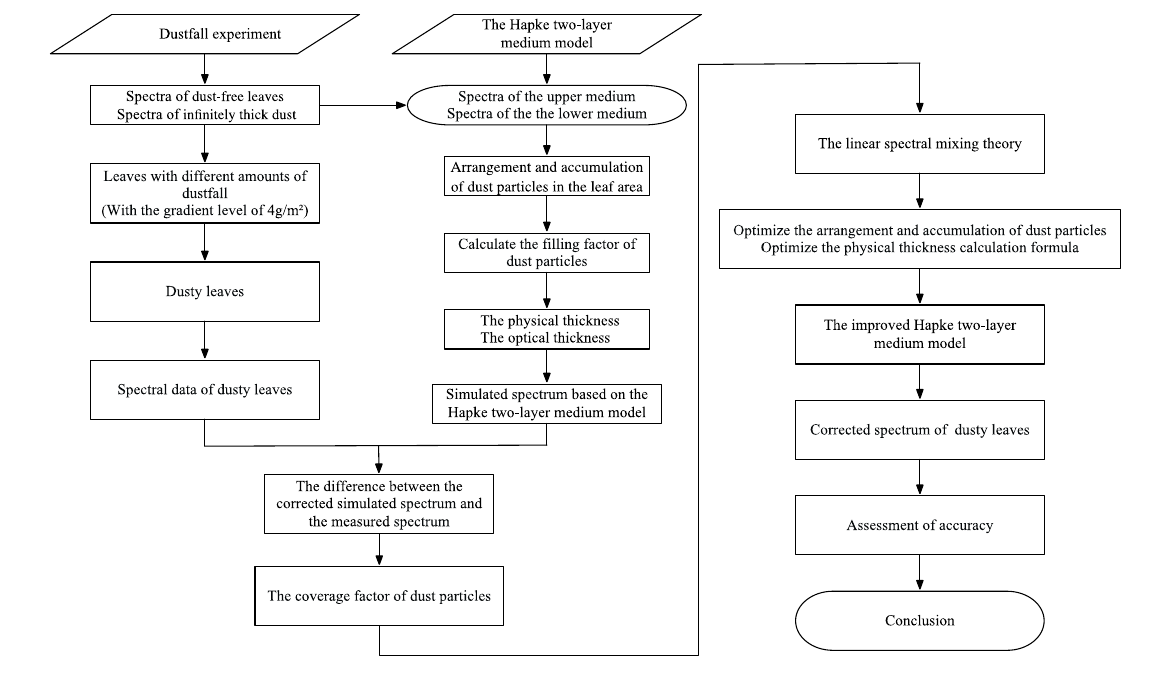
Figure 1. The main experimental procedure of this study.